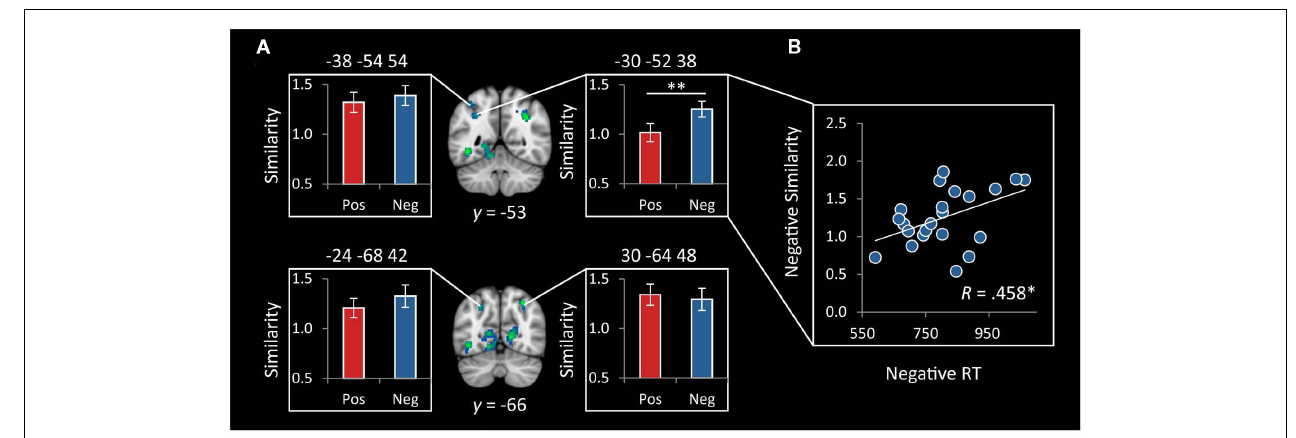
functional cluster centered at ( − 30, − 52, 38) was correlated with reaction time (RT) on negative numbers (* p = 0.032), such that more distinct representations were associated with faster reaction times. ROIs were 10mm spheres generated around peaks of differential IPS response to negative vs. positive